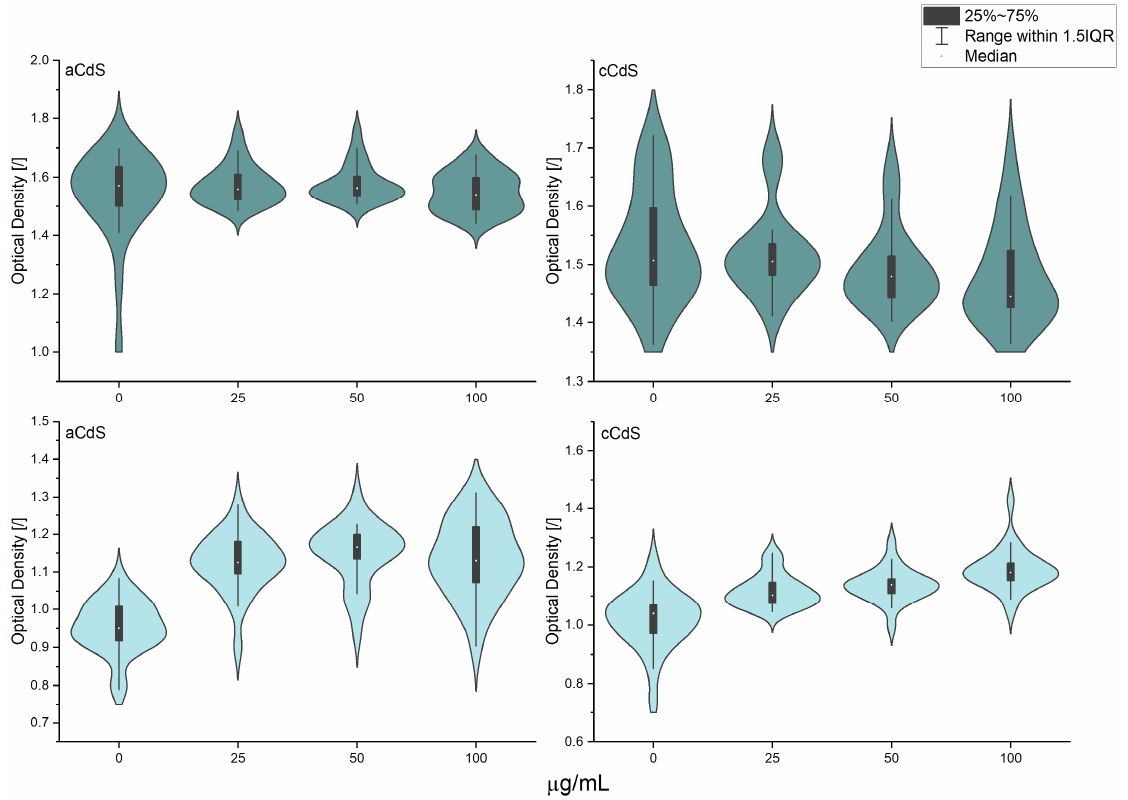
Figure 13. Optical density of 24-h cultures of S. aureus (first row) and E. coli (second row) contacted with CdS nanoparticles or deionized water.